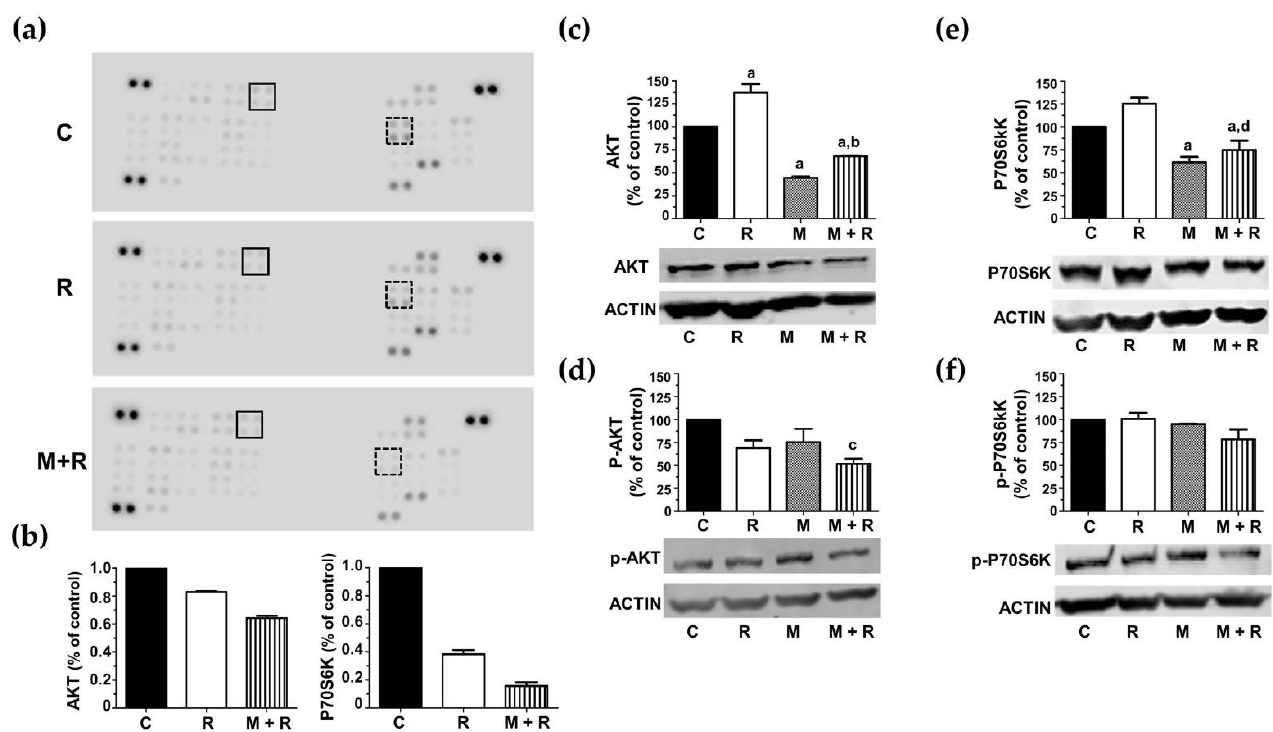
Figure 6. Effects of melatonin and radiation on the phosphorylation levels of Akt and p70S6 kinases. ( a ) Representative images of Proteome Profiler array blots assessed with protein extracts from MCF-7 control cells (C), radiated (R) or pre-treated with melatonin before radiation (M + R). Dots corresponding to Akt are shown in black square and p70S6K dots are shown in dotted square; ( b ) bar chart compiling quantification densitometry data of Akt dots and p70S6K dots, expressed as percentage of control cells; ( c ) western blot detection of total Akt; ( d ) western blot detection of phosphorylated Akt (Ser473); ( e ) western blot detection of total P70S6 kinase; ( f ) western blot detection of phosphorylated P70S6 kinase (Thr389). Bar charts from western blots are expressed as percentages of control non-radiated cells , using β -actin, as a loading control. a, p ≤ 0.01 vs. C; b, p ≤ 0.01 vs. R; c, p ≤ 0.05 vs. C; d, p ≤ 0.001 vs. R.